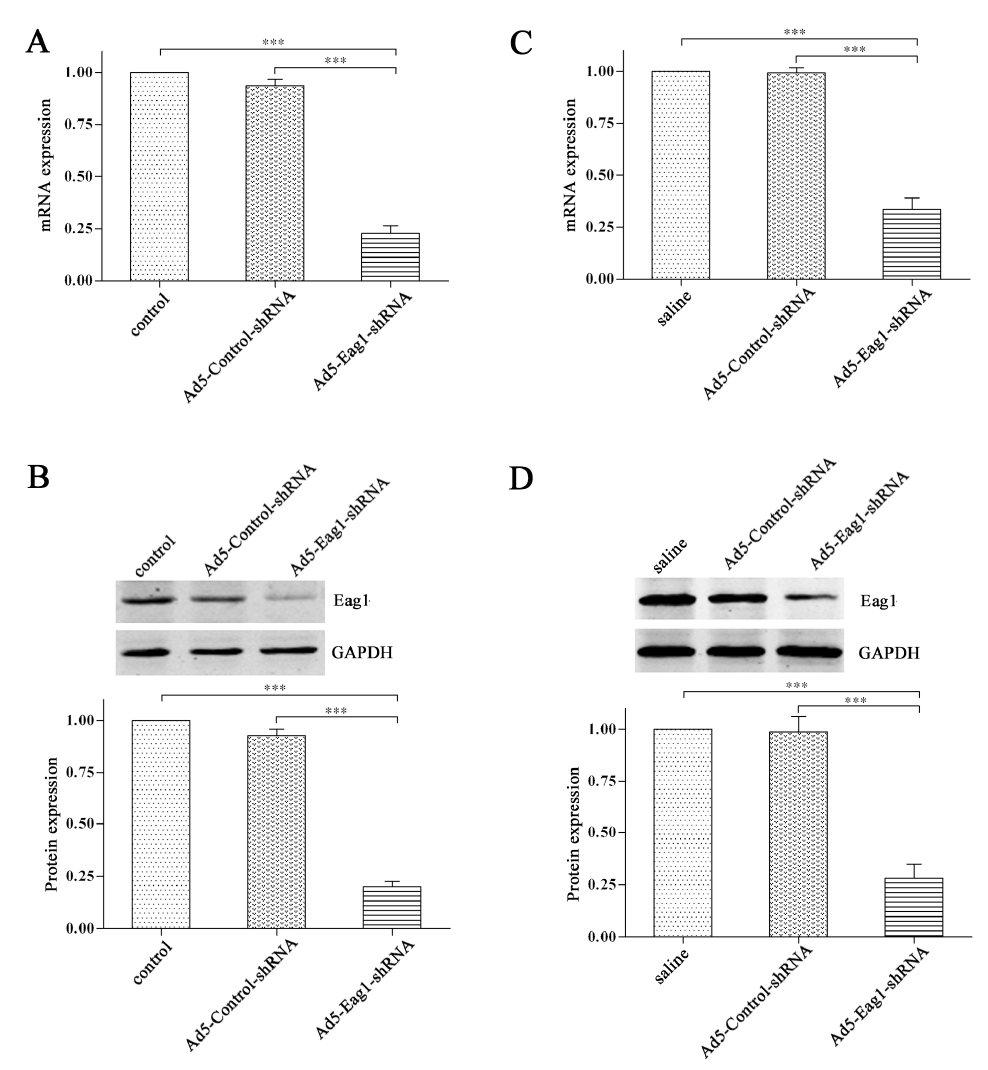
Figure 1. High interference efficiency of Ad5-Eag1-shRNA. ( A ) In vitro experiment showed that the expression of Eag1 mRNA in the Ad5-Eag1-shRNA group was significantly lower than that in the control group or Ad5-Control-shRNA group. ( B ) Grey-value analysis of western bolt was completed using GAPDH as the internal reference, and the results were expressed as mean ± SD ( n = 3). ( C , D ) Similar results were obtained from in vivo experiment. *** p <